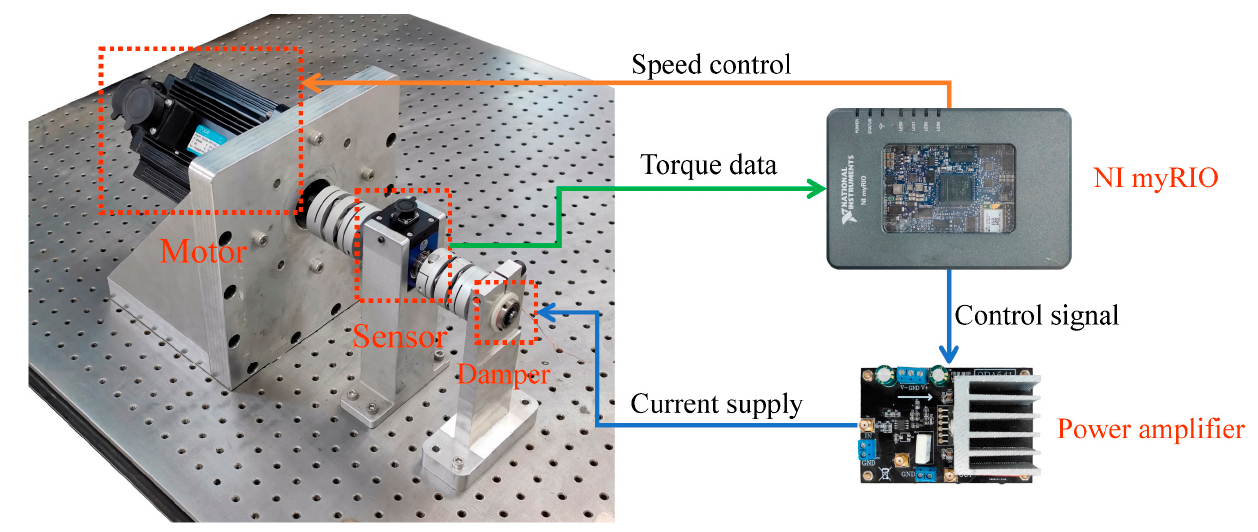
Figure 5. Experimental setup for the torque test including motor, torque sensor, MR damper, and other connection and location fixing parts. other connection and location fixing